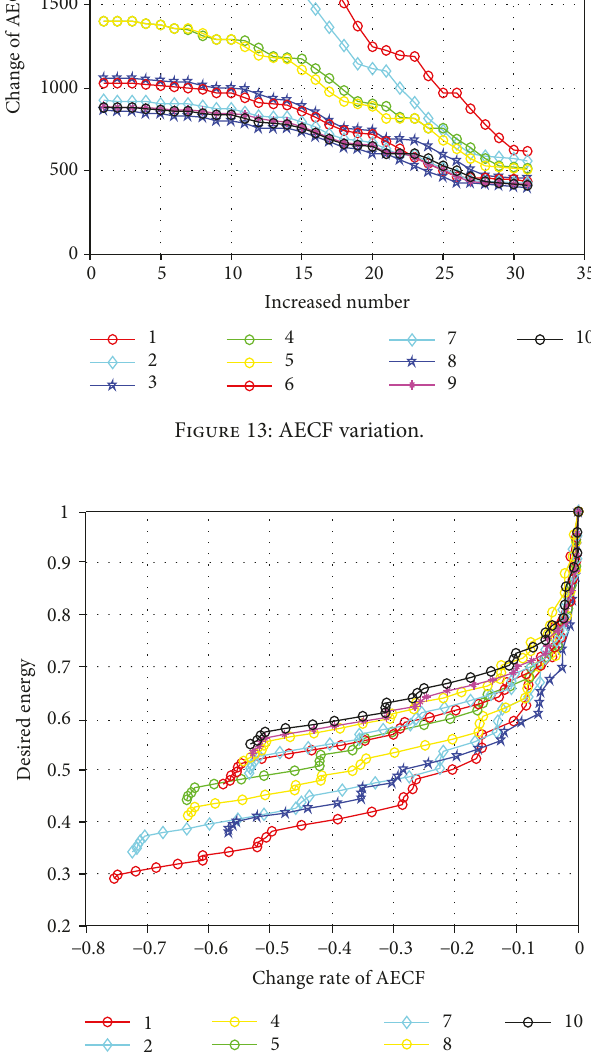
Figure 14: AECF and energy demand.